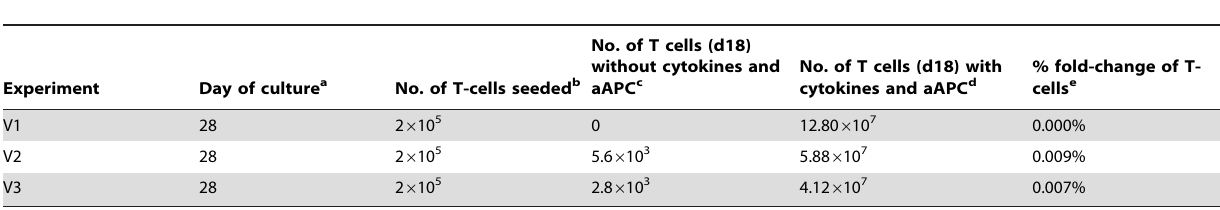
Table 2. Lack of autonomous cell growth by genetically modified T